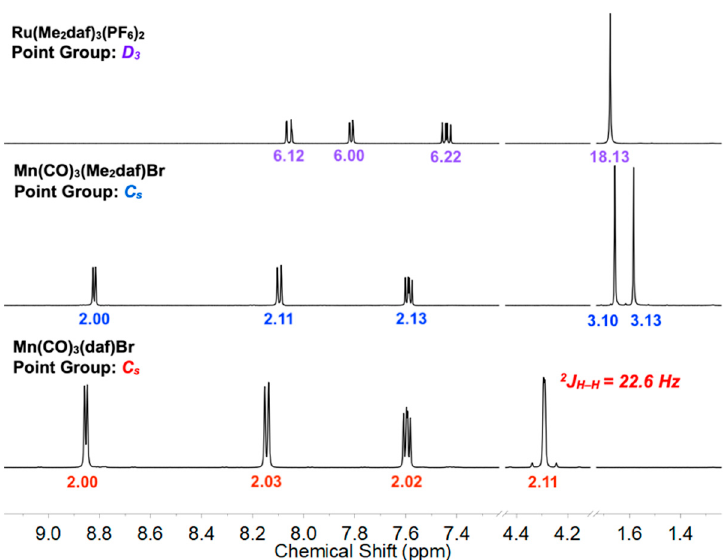
Figure 1. Partial 1 H NMR spectra of 2 (bottom), 3 (middle), and 5 (top) in CD 3 CN. Peak integrations are given beneath each resonance or multiplet in colored text.